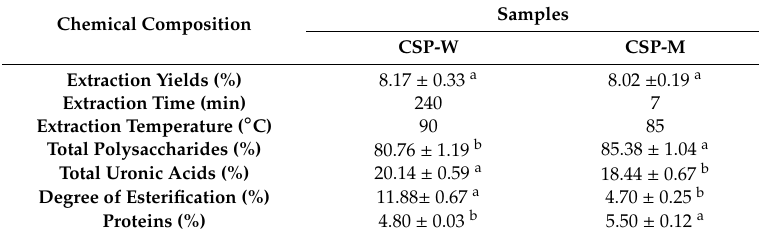
Table 3. Extraction conditions and chemical composition of CSP-W and